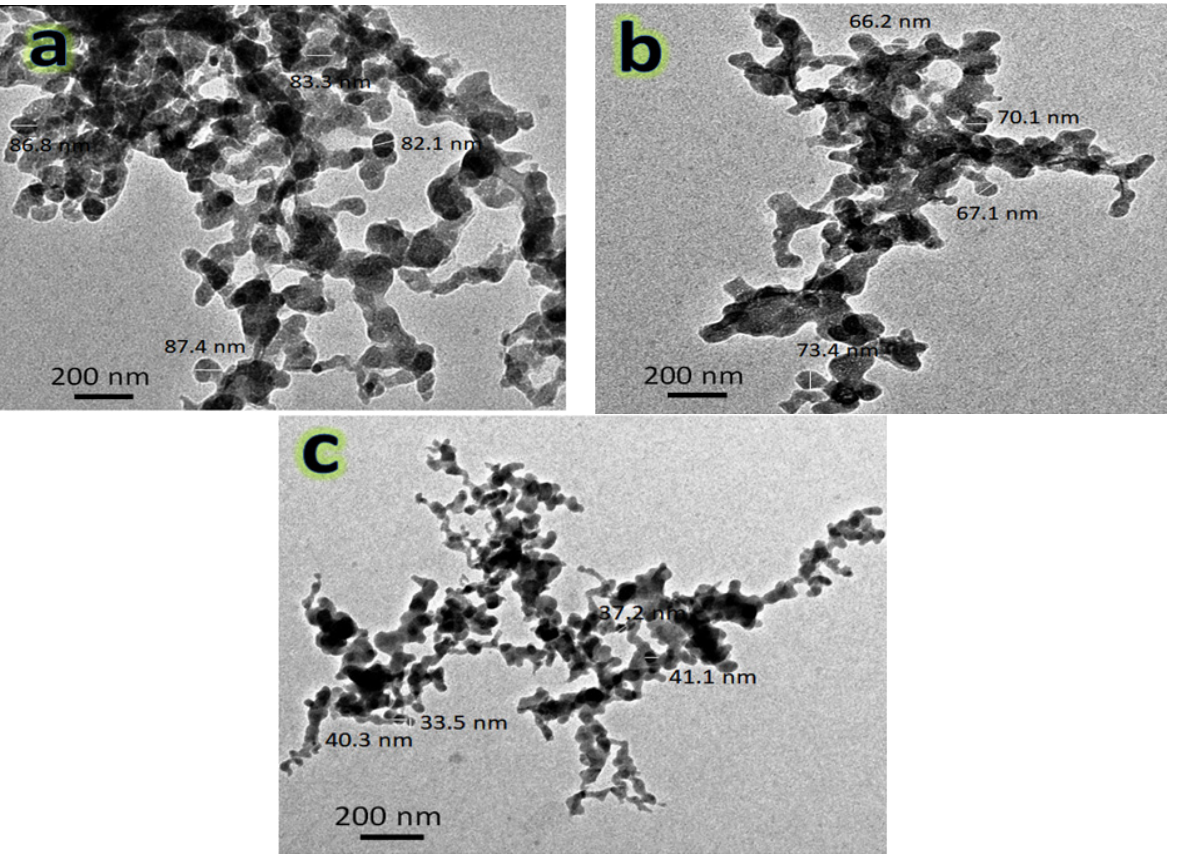
Figure 5. TEM micrographs of ( a ) FNG0, ( b ) FNG4, and ( c ) FNG8 nanocomposite powders after 10 h of milling.